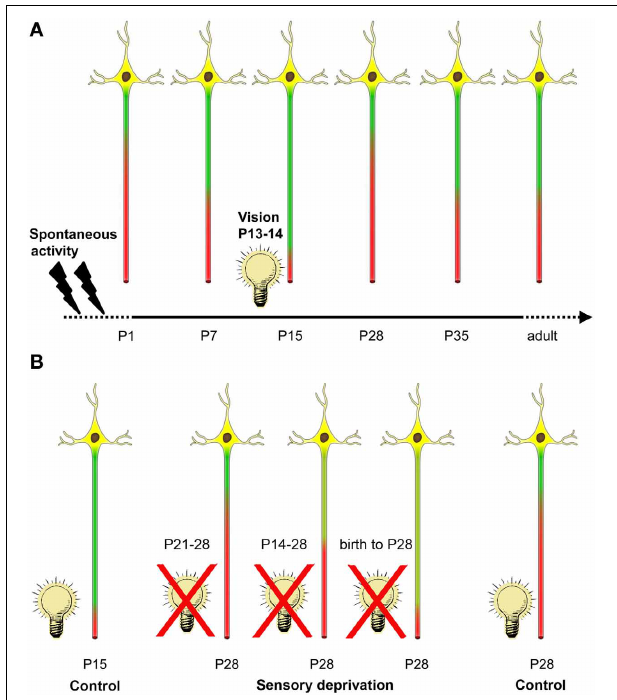
FIGURE 7 | Summary of activity-dependent AIS maturation in visual cortex. (A) Spontaneous activity in form of retinal waves and intrinsic network activity along the developing visual system is present during the embryonic and early postnatal period (indicated by flashes). AIS length maturation is characterized by a tri-phasic time course of structural remodeling. First, during the early postnatal period, AIS steadily increase in length until a maximum is reached at P15. Coincidentally, between P13–14, mice of this strain open their eyes and receive visual input for the first time (indicated by light bulb). Shortly after eye opening, a striking AIS length shortening occurs. After the peak of the critical period at P28, AIS undergo another phase of length remodeling and increase to maintain mature length throughout adulthood. (B) A 1 week sensory deprivation (P21–28) in mice that have undergone eye opening and therefore AIS shortening did not alter AIS length compared to controls at P28 (far right neuron). However, a 2 week deprivation that began around the time of eye-opening (P14–28) was sufficient to prevent AIS length shortening compared to P28 controls. This effect was even more pronounced in dark reared (birth to P28) animals. Strikingly, this last deprivation group also showed similar AIS length distribution as the juvenile AIS group at P15 during normal development (far left